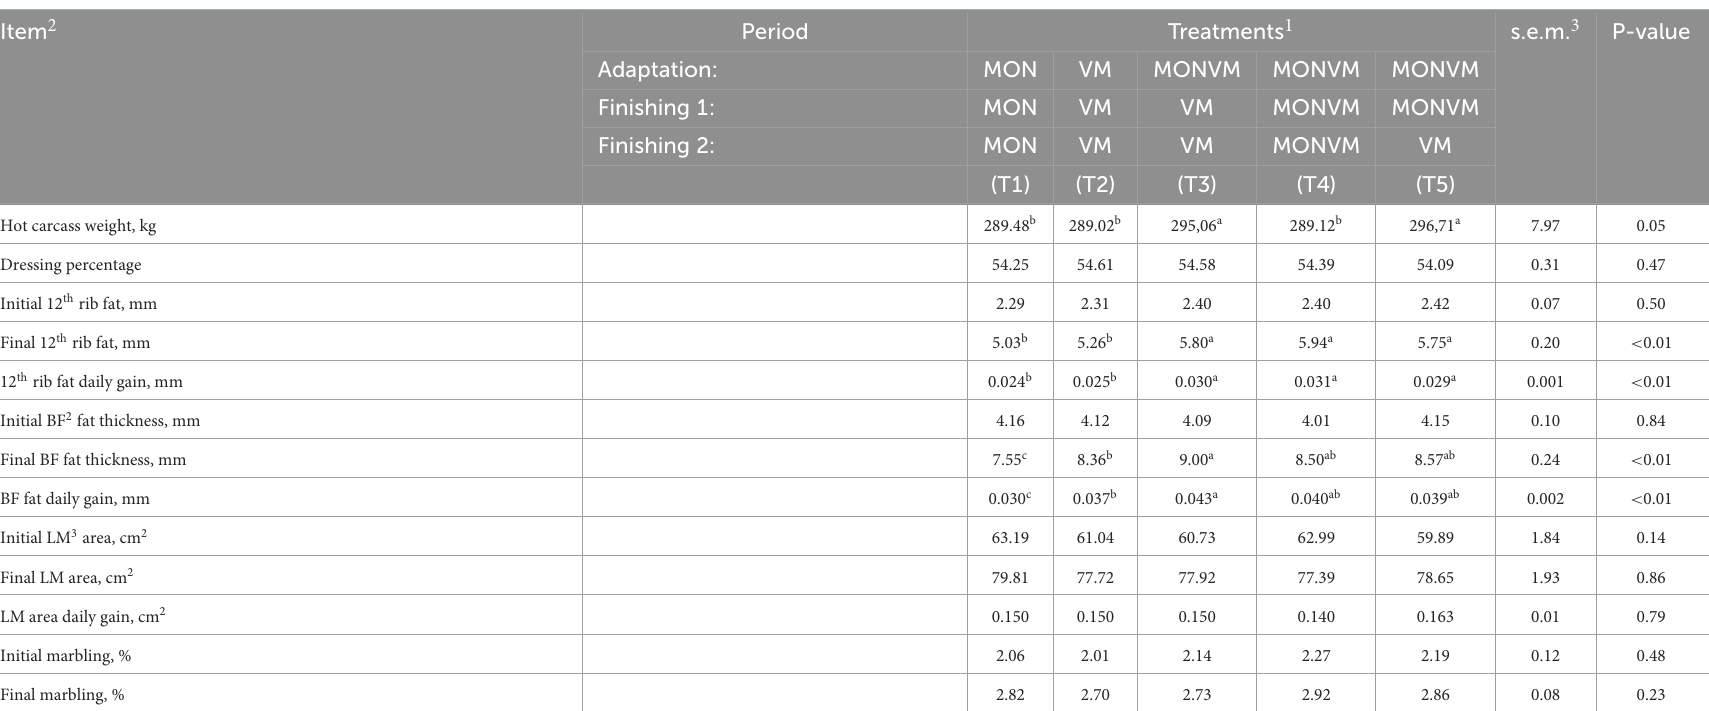
TABLE 3 Withdrawal of sodium monensin when associated with virginiamycin during adaptation and finishing periods on carcass characteristics of Nellore yearling bulls ( n = 30) consuming high-concentrate diets. Item 2